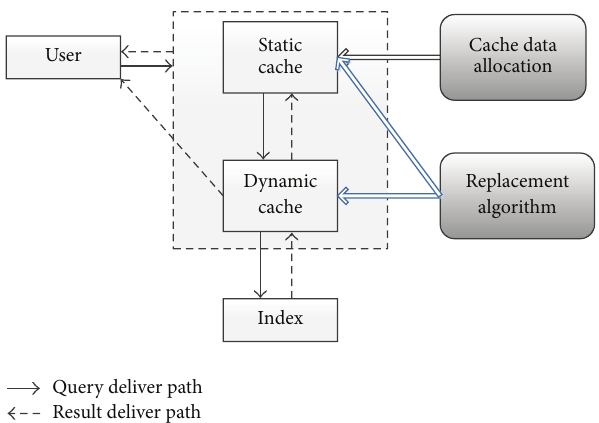
Figure 1: Collaborative mechanism of static and dynamic